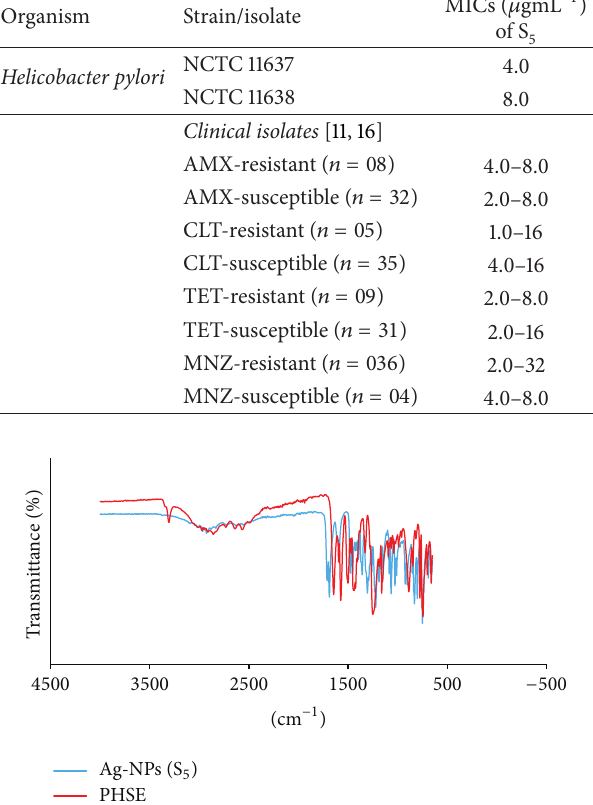
Figure 3: (a) FT-IR spectra of PH-sus and (b) FT-IR spectra of Ag- NPs (S 5 ).